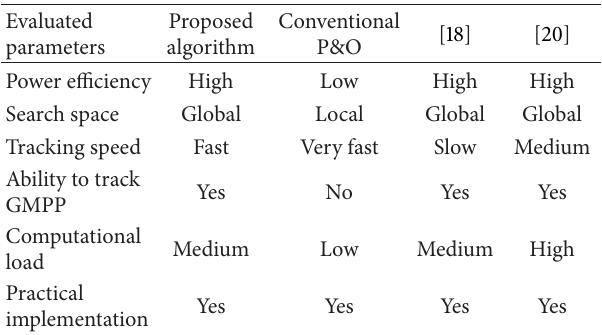
Table 2: Comparison of the proposed algorithm to conventional P&O [18,